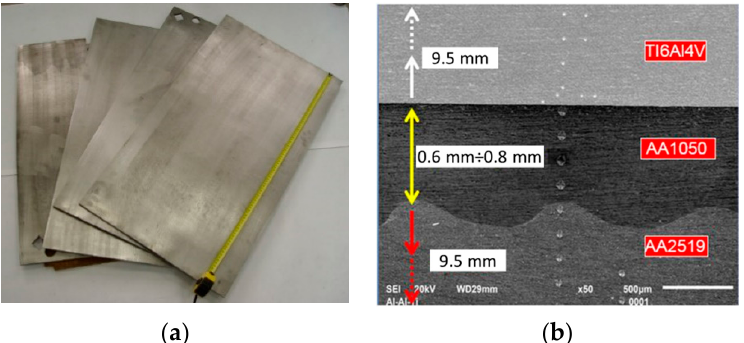
Figure 1. Laminate AA2519-AA1050-Ti6Al4V: ( a ) sheets produced, ( b ) metallographic cross-section of the composite.